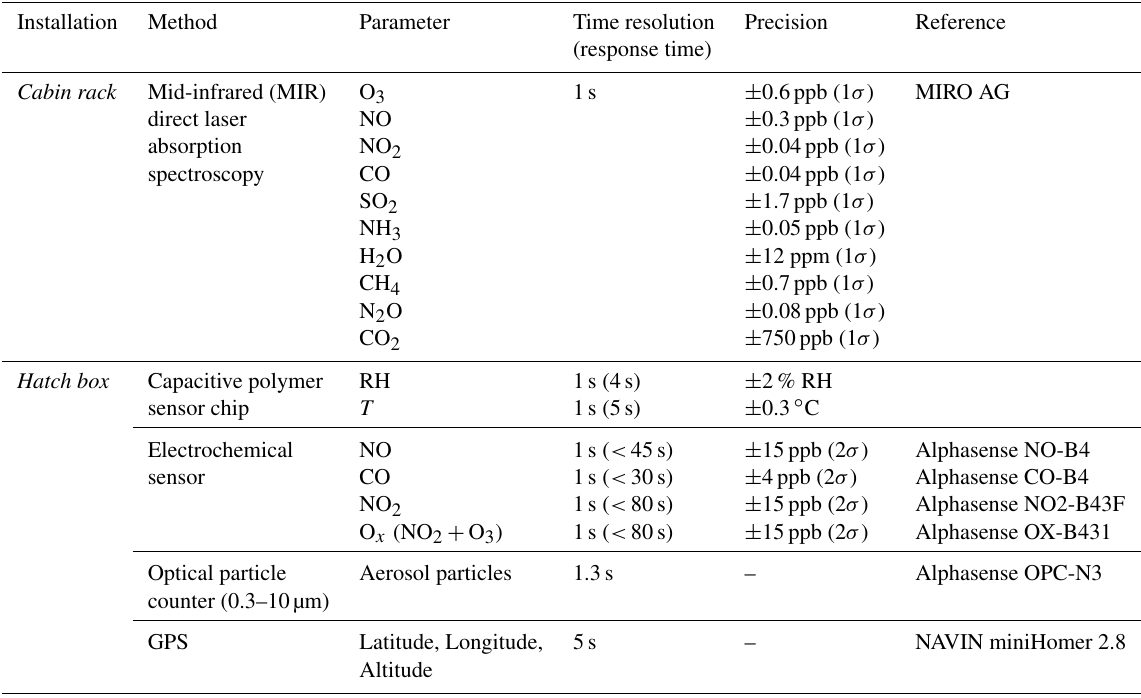
Table 2. Instrumentation onboard the Zeppelin airship. Installation Method Parameter Time resolution Precision Reference